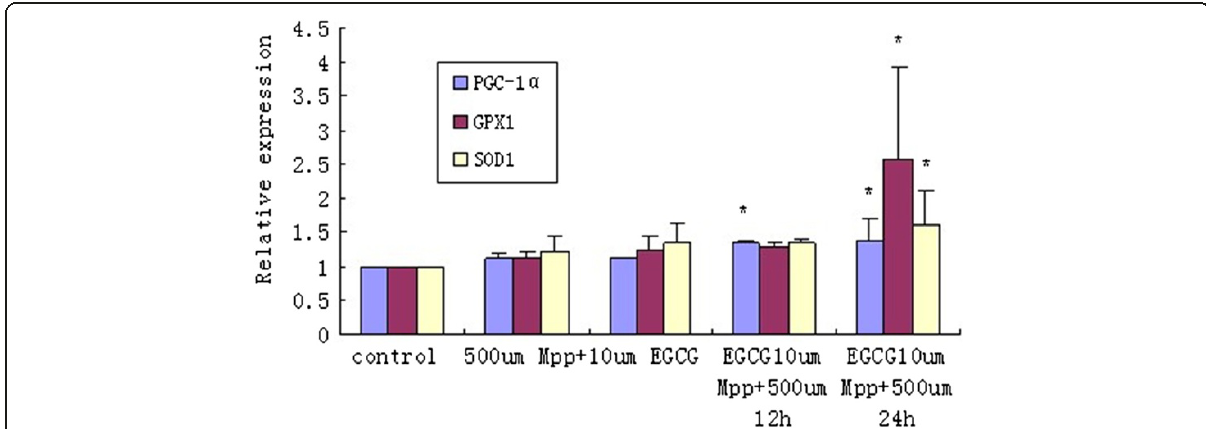
Figure 4 Effect of MPP + and EGCG on PGC-1 α , GPX1 and SOD1 mRNA expression in PC12 cells. Groups were: control, 500 μ mol/L MPP + , 10 μ mol/L EGCG, 10 μ mol/L EGCG +500 μ mol/L MPP + for 12 h (treatment with EGCG for 30 min, followed by MPP + for 12 h), 10 μ mol/L EGCG+500 μ mol/L MPP + for 24 h (treatment with EGCG for 30 min, followed by MPP + for 24 h). Results show that PGC-1 α mRNA expression